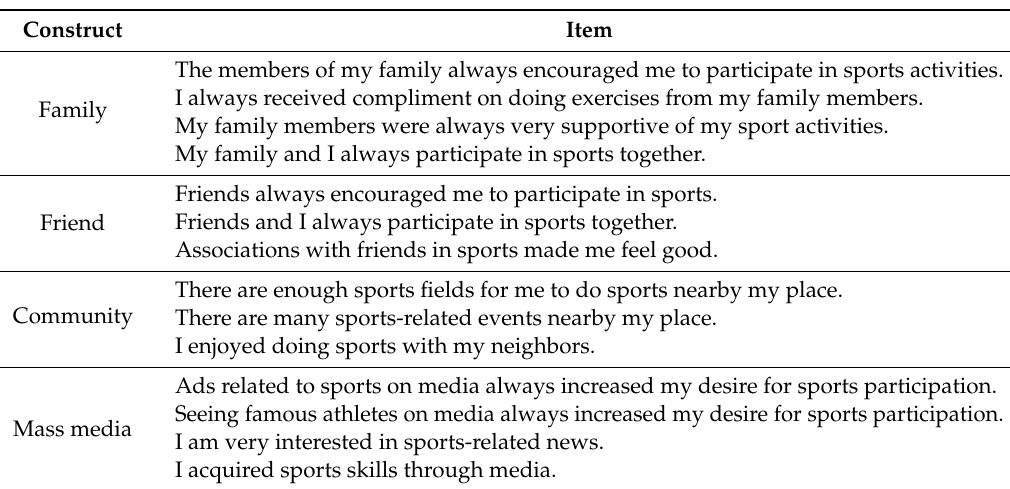
Table A2. Measurement of agents of socialization.